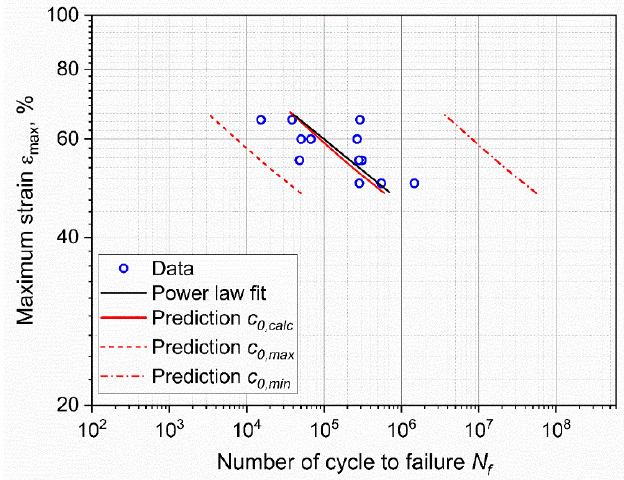
Figure 17. Comparison between fatigue data and the calculated fatigue lifetimes for the calculated defect size ( c 0 ,calc ), and the maximum and minimum sizes evaluated from μ-CT ( c 0 ,max and c 0 ,min , re- spectively). c 0, min ,